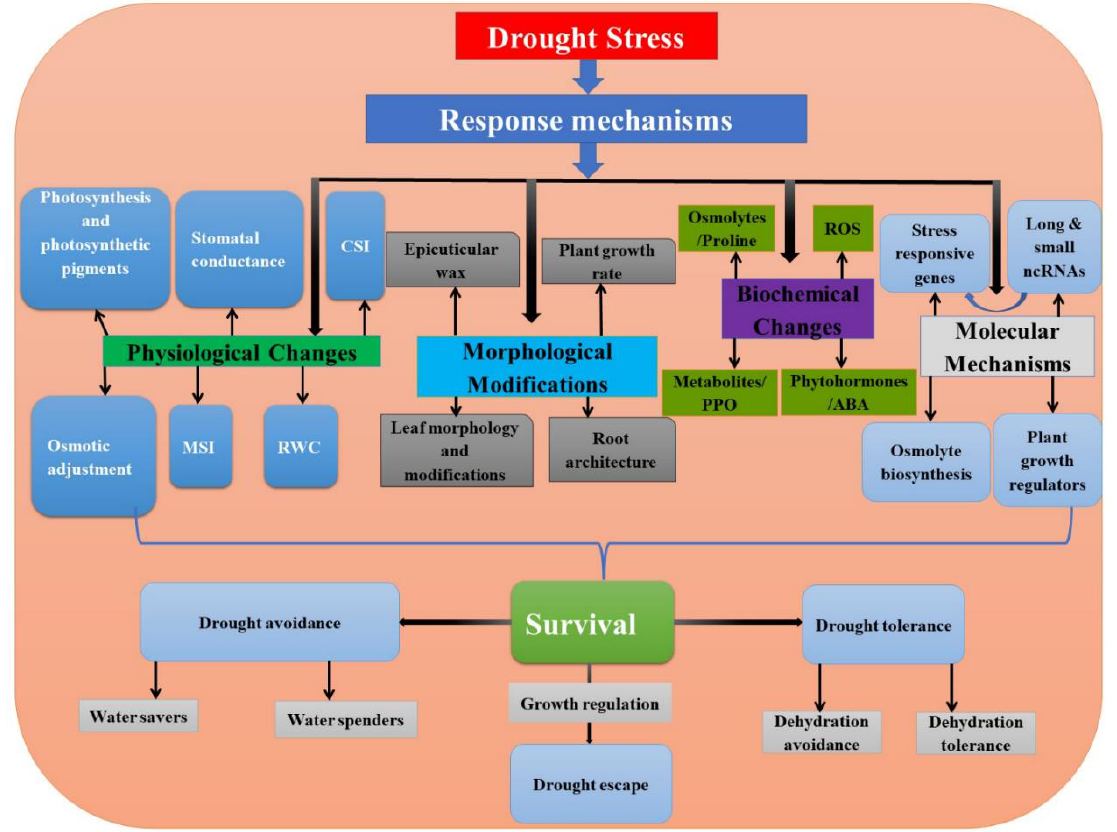
Figure 1. Schematic representation of different drought stress-response mechanisms operative in plants. The combined actions of these processes govern plant survival or susceptibility. The survival of plants can be grouped under drought avoidance, drought tolerance and drought escape, based on the plant response. ABA = abscisic acid, CSI = chlorophyll stability index, MSI = membrane stability index, PPO = polyphenol oxidase, ROS = reactive oxygen species, RWC = relative water